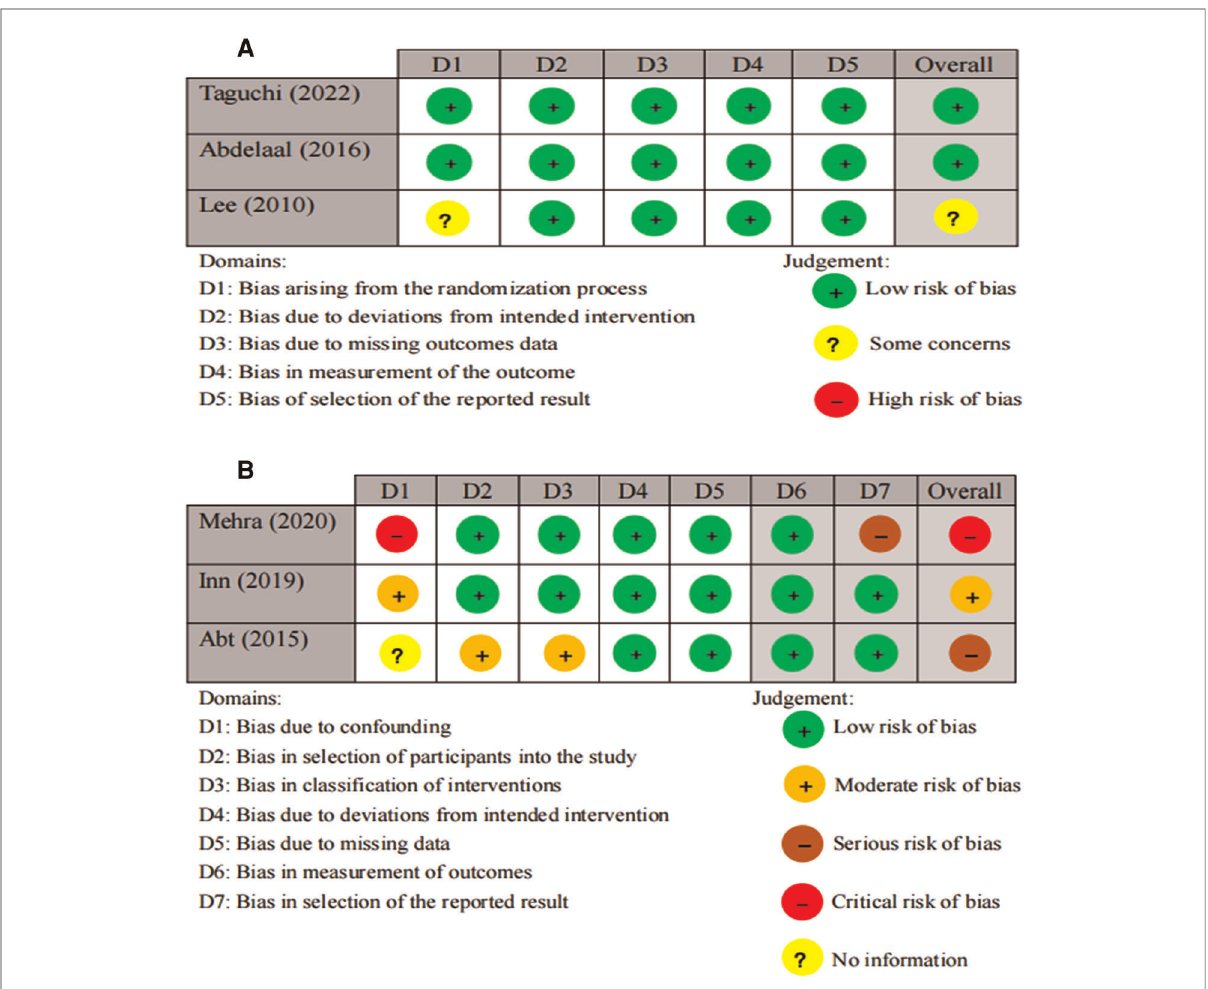
FIGURE 2 Risk of bias graph of the included studies. ( A ) Risk of bias rating of RCTs using ROB2. ( B ) Risk of bias rating of non-RCTs using